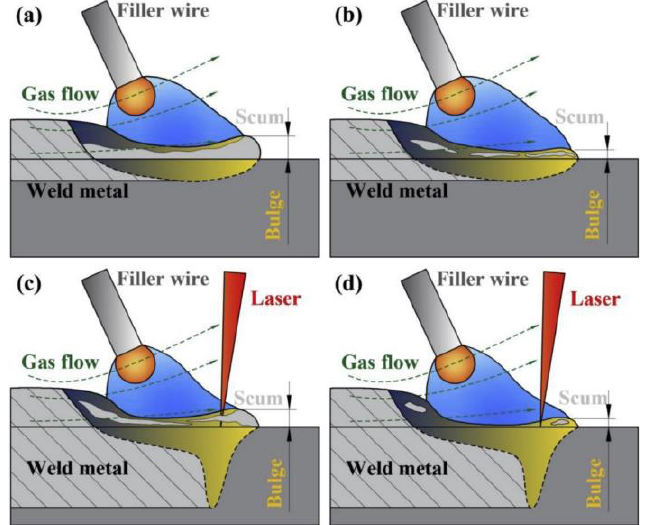
Figure 17. Schematic diagrams of molten pool: ( a ) MIG(2.1 m/s), ( b ) MIG(6.4 m/s), ( c ) LAHW(2.1 m/s), ( d ) LAHW(6.4 m/s) [88]. Reprinted with permission from [88] 2019 Elsevier. Whether laser welding or arc welding, shielding gas is the vital factor affecting the process characteristics. In laser welding, especially CO 2 laser welding, shielding gas is an effective means to eliminate the plasma shielding effect, improve process stability, and realize deep penetration welding. In arc welding, shielding gas is the vital factor to